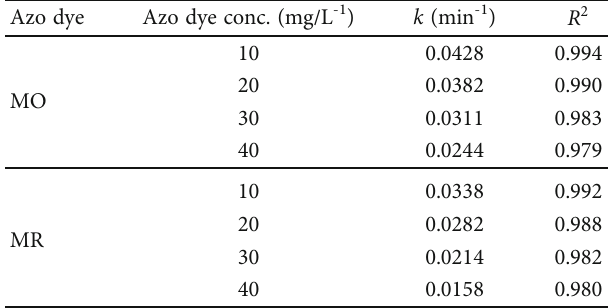
Table 1: Kinetic parameters for photocatalytic degradation of MO and MR dyes. Azo dye Azo dye conc. (mg/L -1